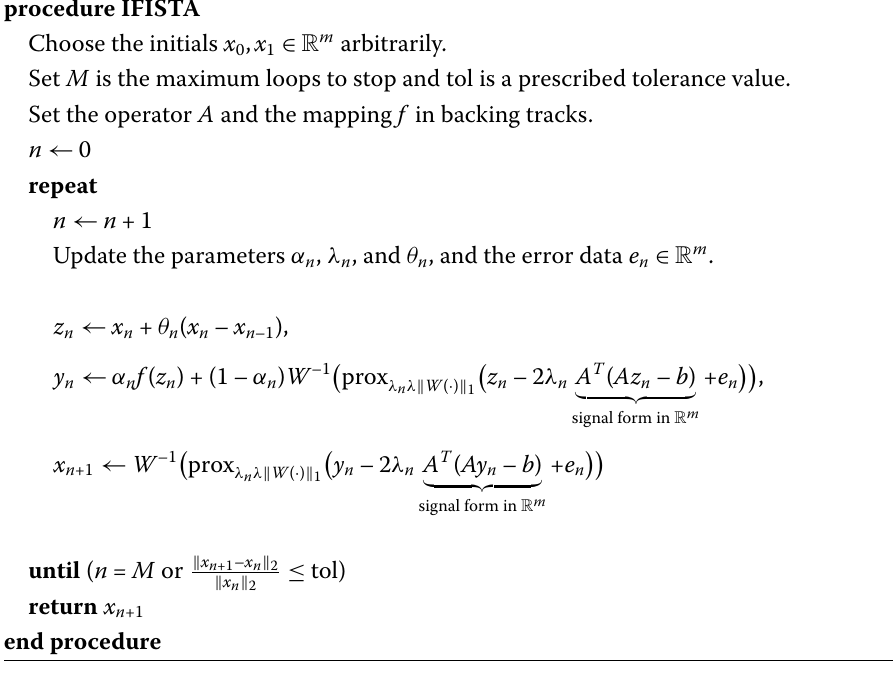
Algorithm 1 Improved fast iterative shrinkage thresholding algorithm (IFISTA). procedure